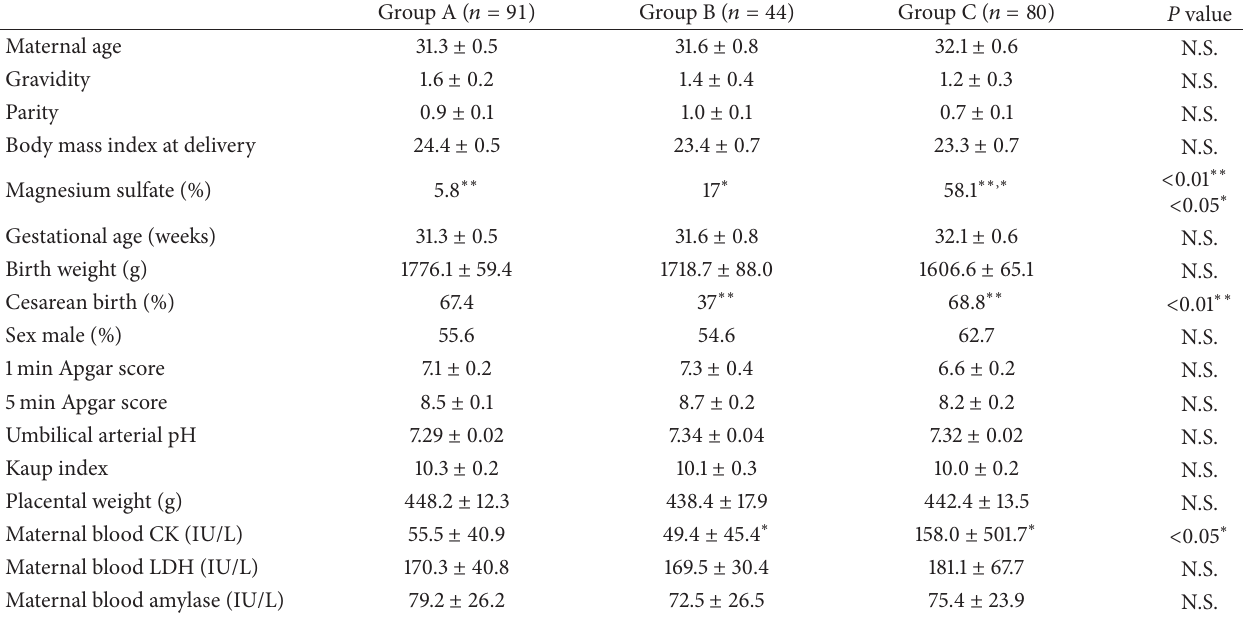
Table 1: Clinical backgrounds of the three groups.